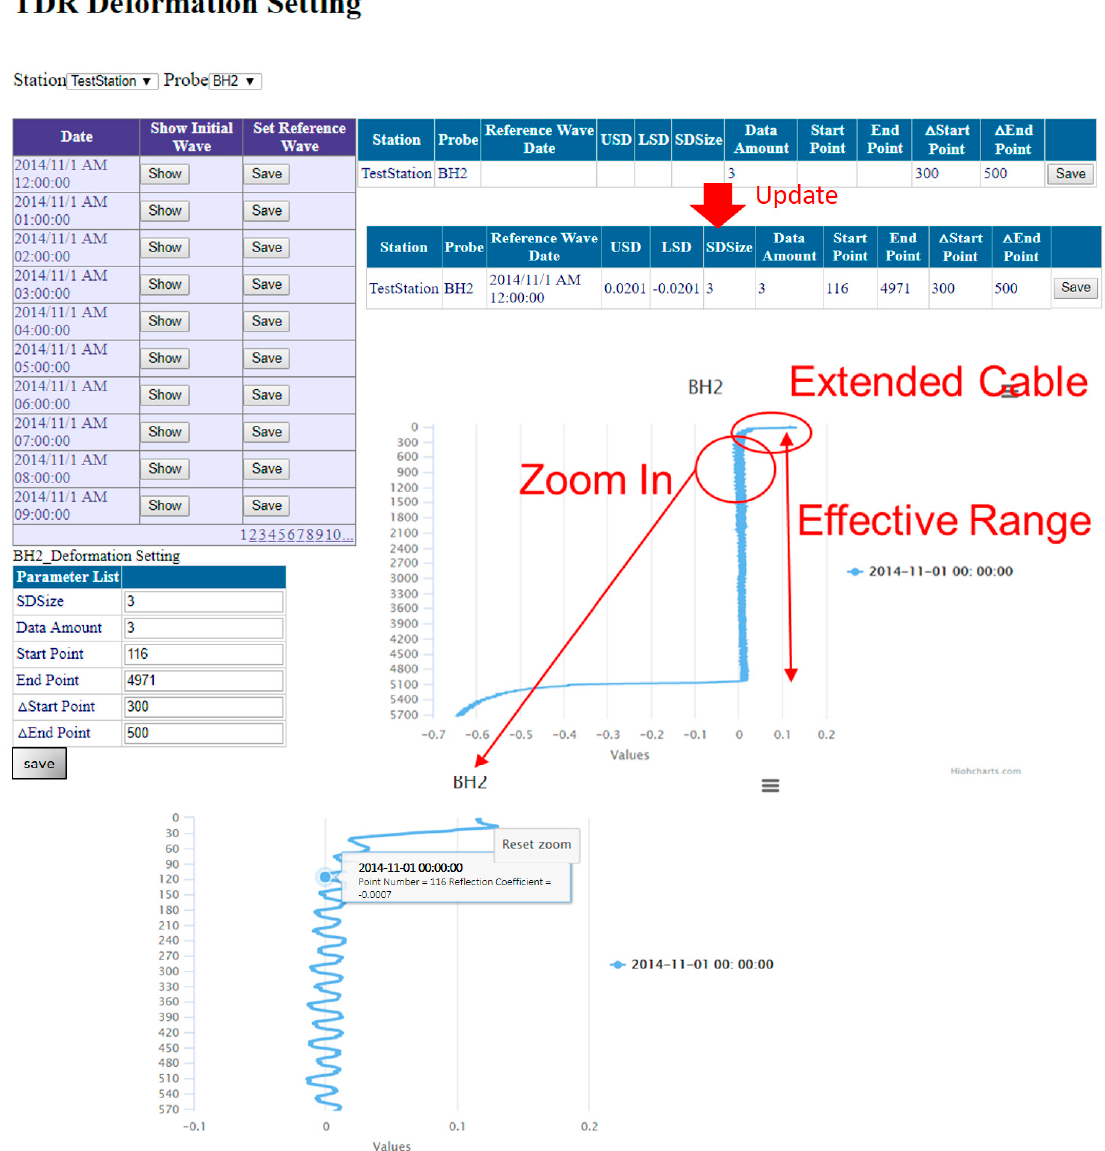
Figure 19. TDR crimp type monitoring setting for reference waveform and e ff ective